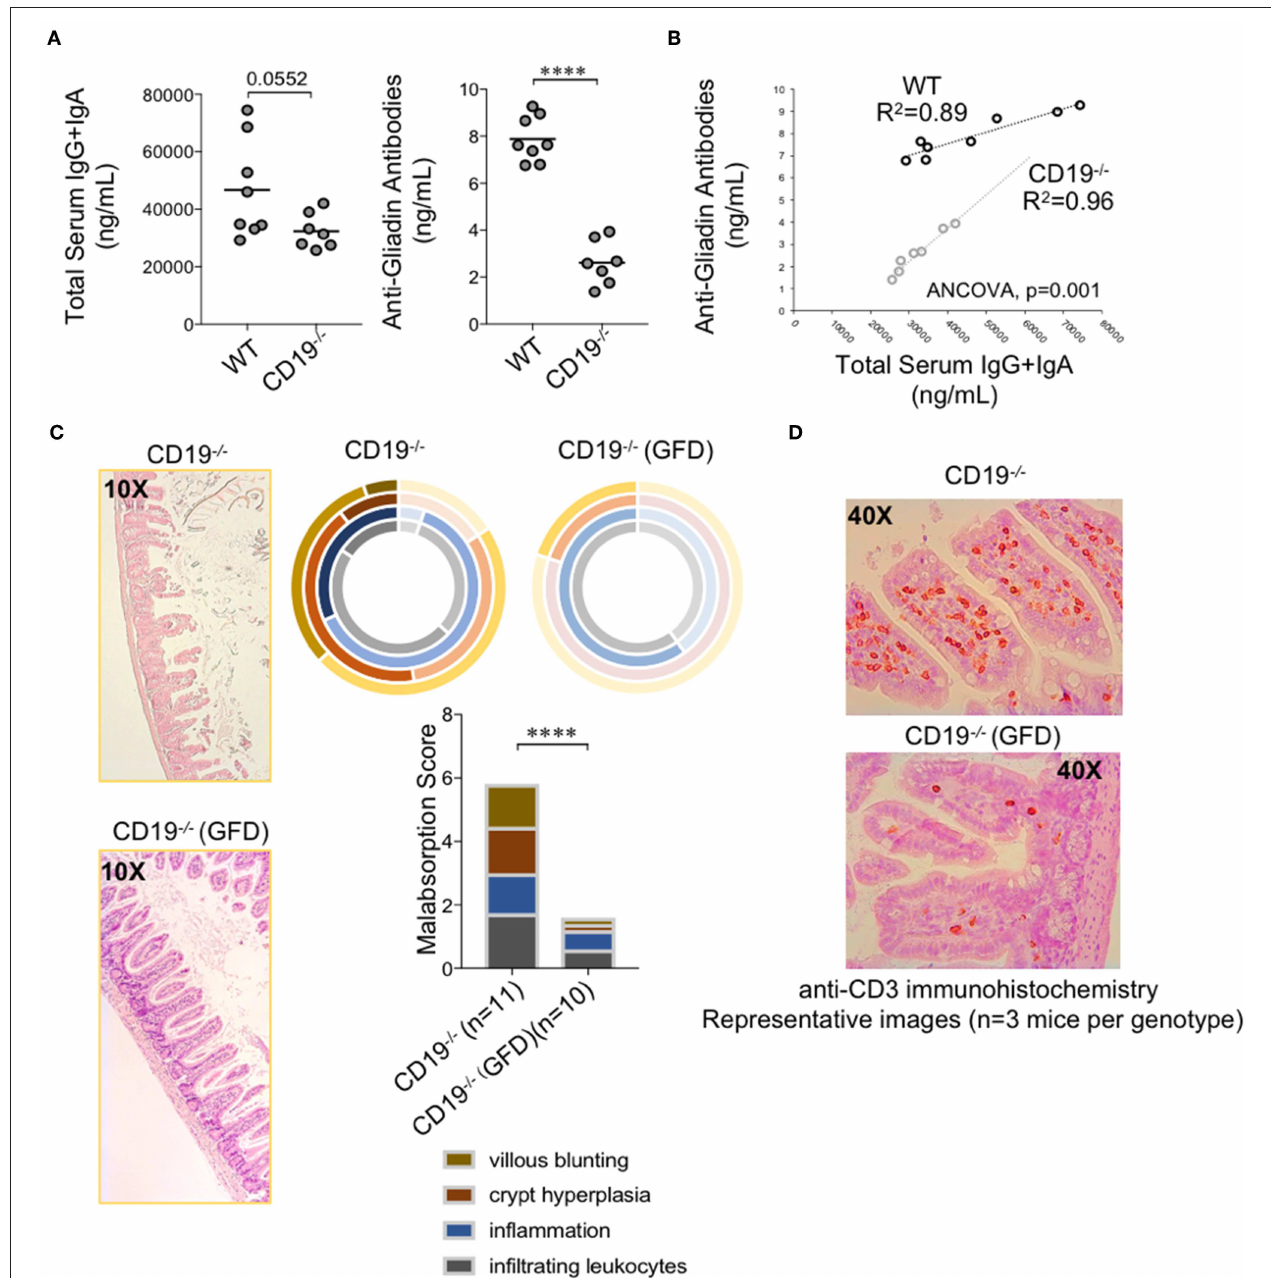
FIGURE 7 | Malabsorption in CD19 − / − mice is gluten-sensitive. (A) Total serum IgG and IgA and total AGA antibody titers are shown. (B) Correlation between AGA antibody titers and total IgG/IgA titers in WT and CD19 − / − mice. (C) Malabsorption scoring for GFD-treated CD19 − / − mice compared to animals reared on a gluten-containing mouse chow. (D) Representative anti-CD3 IHC staining of ileal T cells in CD19 − / − mice treated with GFD vs. controls. (A) Student’s t-test, **** = p < 0.0001. (C) Result of Two-way ANOVA (row factor = genotype), **** = p < 0.0001.